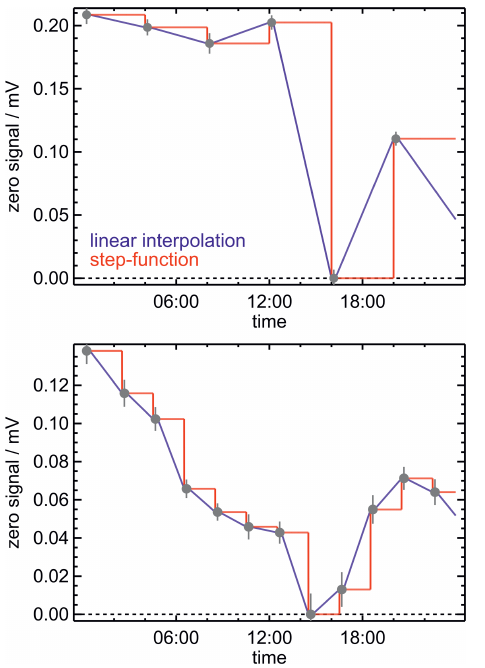
Figure 1. Plots showing 2d of instrument zero measurements. In each plot, the variation in the instrument zero over time is plotted using a step function (i.e. only the most recent zero measurement is considered) and using the linear interpolation between two suc- cessive zero measurements. Each error bar represents the 1 σ error in the zero measurement. The change in the raw signal, 0.2 mV, corresponds to a HCHO mixing ratio of 1.2ppbv.